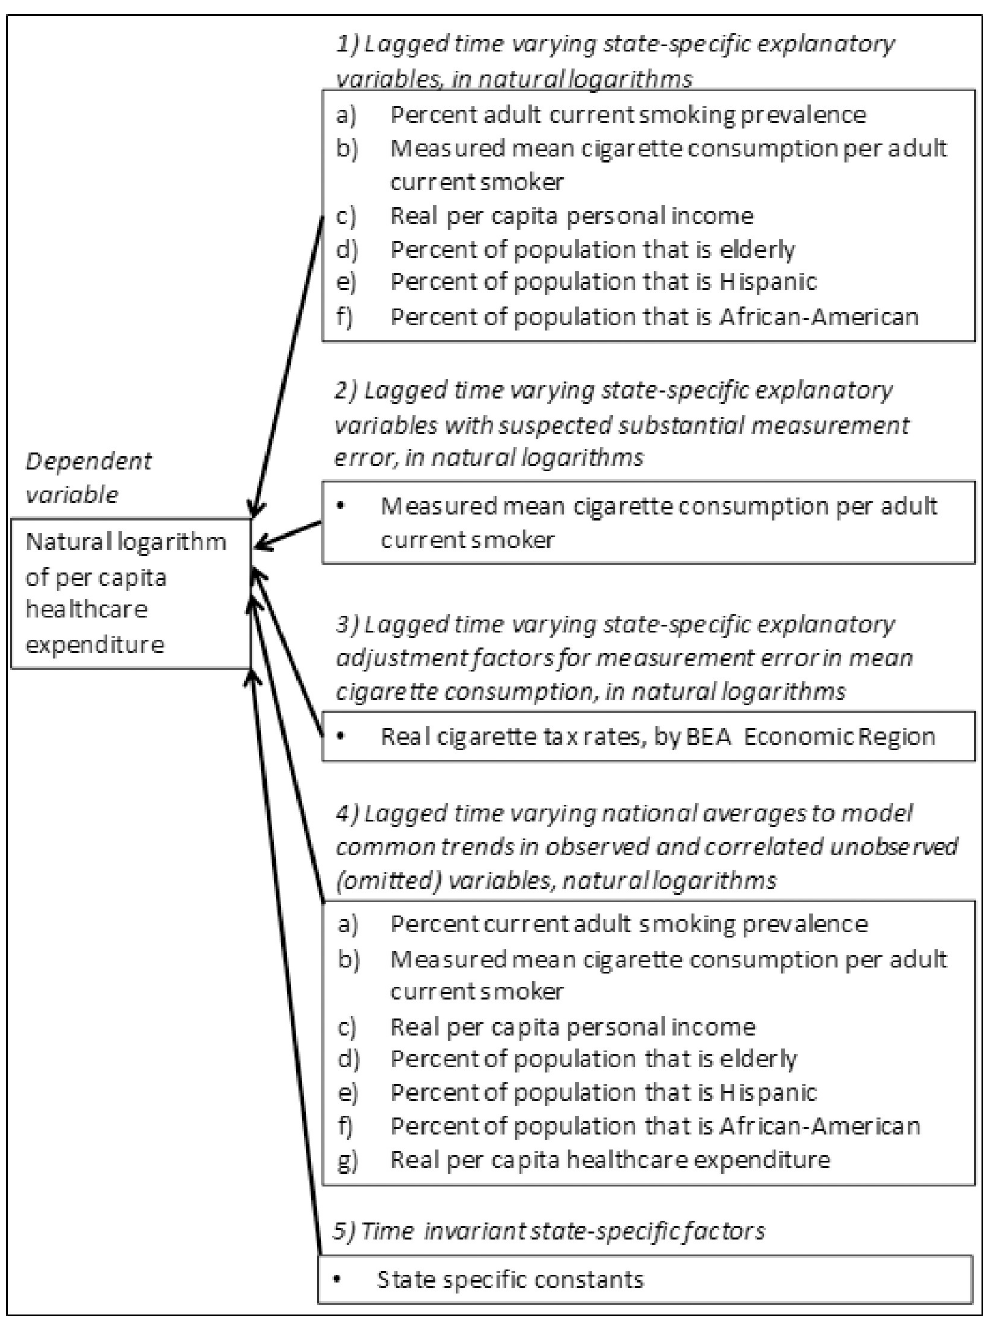
Fig 1. Structure of panel data regression model (Adapted from Lightwood J, Glantz SA. Smoking behavior and healthcare expenditure in the United States, 1992–2009: Panel Data Estimates. PLoS Med. 2016;13(5):e1002020)